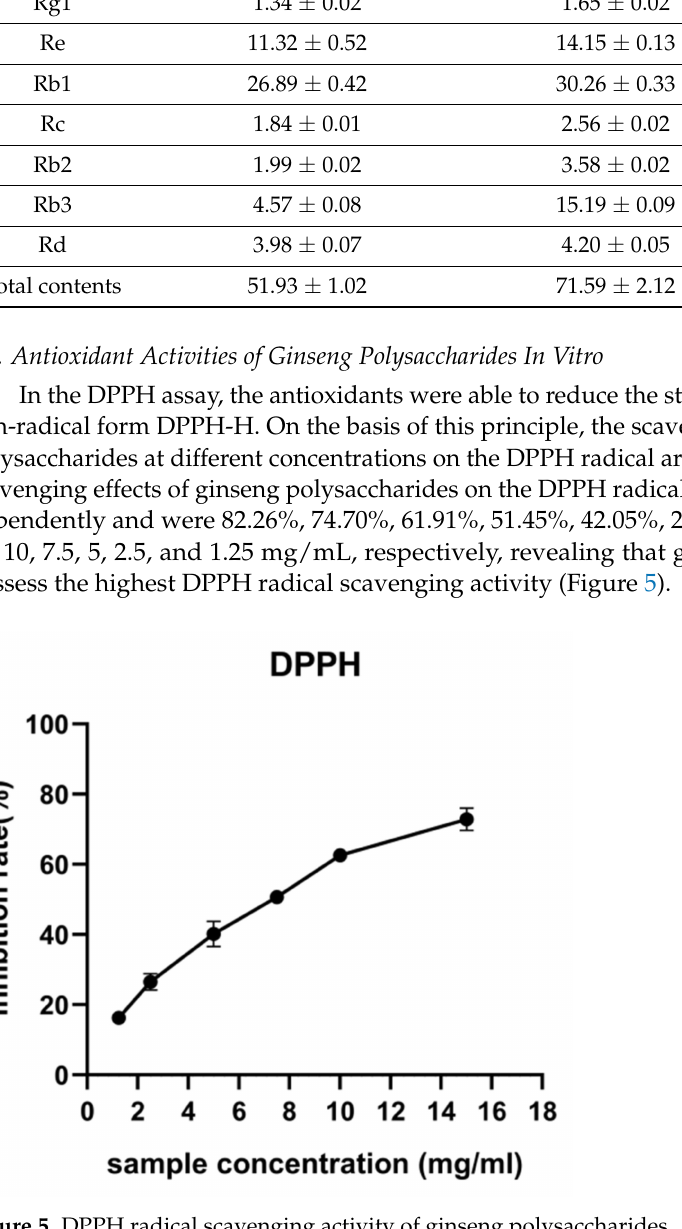
Figure 5. DPPH radical scavenging activity of ginseng